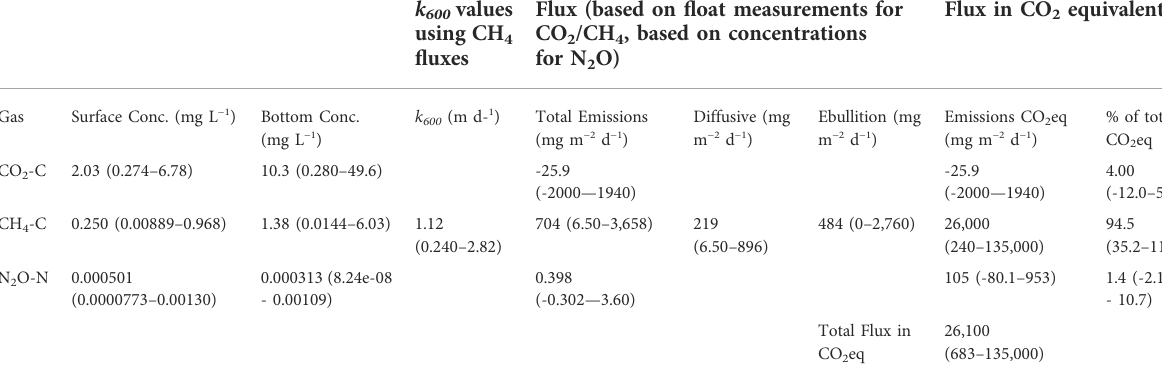
k 600 values Flux (based on fl oat measurements using CH 4